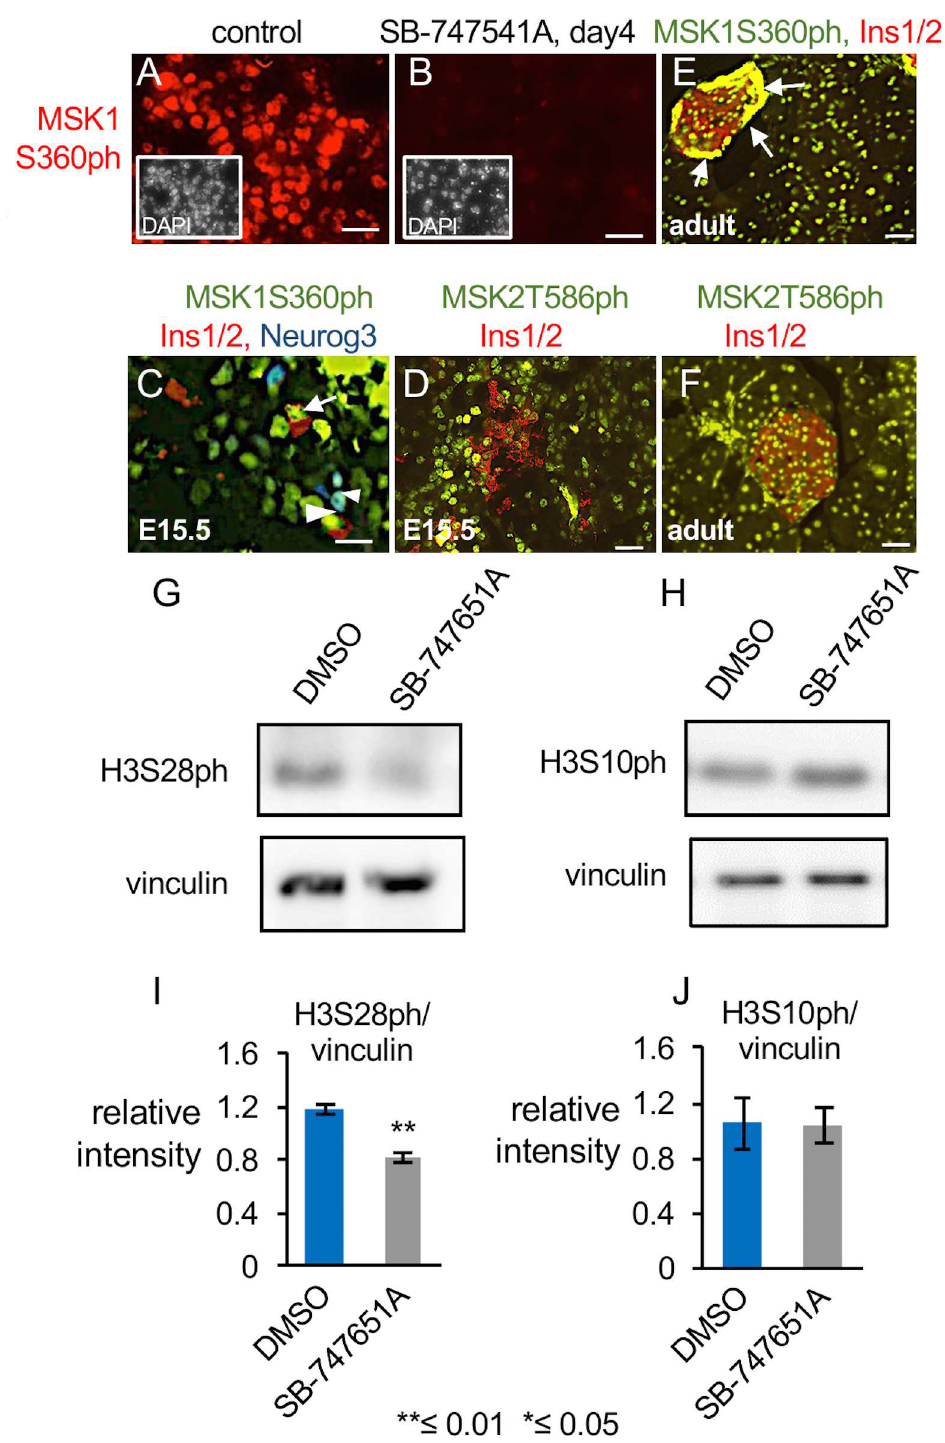
Fig 3. MSK1/2 is expressed in the pancreatic epithelium and mediates phosphorylation of Histone H3 at Ser28. (A, B) Epifluoroscent images showingexpressionof MSK1S360ph and DAPI (inset) in pancreatic sectionsfrom DMSO and SB-747541A treated explantsat E15.5, cultured4 days. DAPI stainedimages (inset) were pseudo-colored white to enhancecontrast. n (cid:21) 5 pancreatafor each staining. Scale bar = 12.5 μ m. (C-F) Expression of the indicatedproteinsin pancreaticsectionsfrom E15.5 stage (C, D) and (E, F) adult islets. Arrows in panel C indicateco-expression of MSK1S360ph with Ins1/2 (red), arrowheadsindicate coexpression of MSK1S360phwith Neurog3(blue). Arrows in panel E show high expressionof